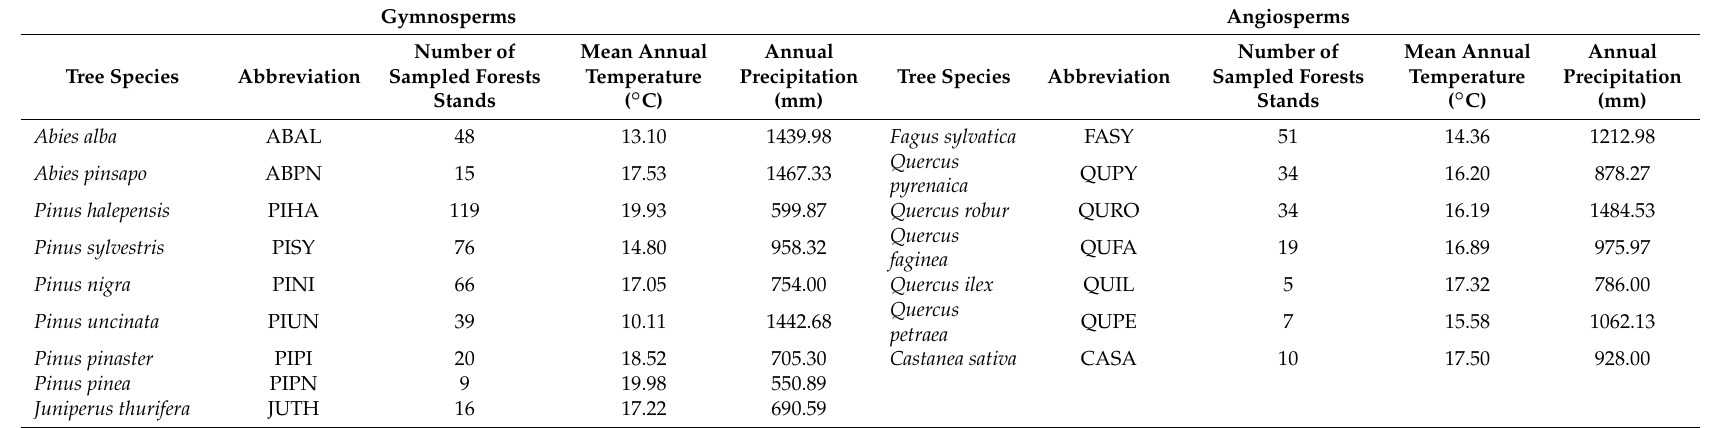
Table 1. List of tree species, abbreviations, and number of the sampled forests stands; including the average mean annual temperature and precipitation of each tree species